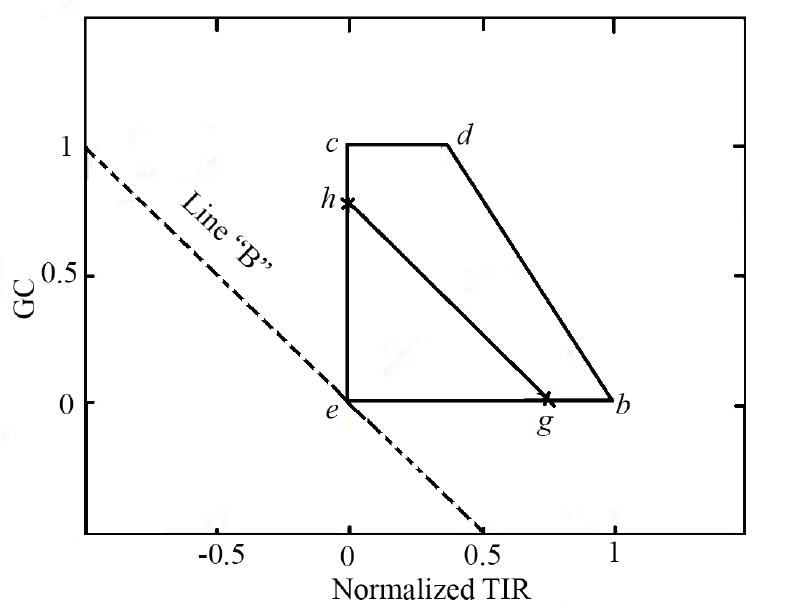
Figure 4. Points g and h are the same perpendicular distance from the baseline “B” but are associated with different amounts of soil